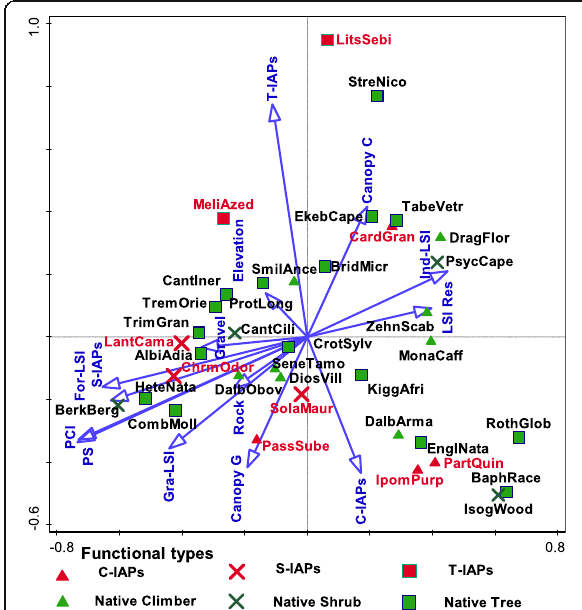
Fig. 4 Constrained ordination CCA of species distribution across the environmental factors studied (see Table 2 for details). Species codes are detailed in Table 3. Blue arrows and corresponding labels represent the environmental factors, while red labels are IAPs and black labels are native species